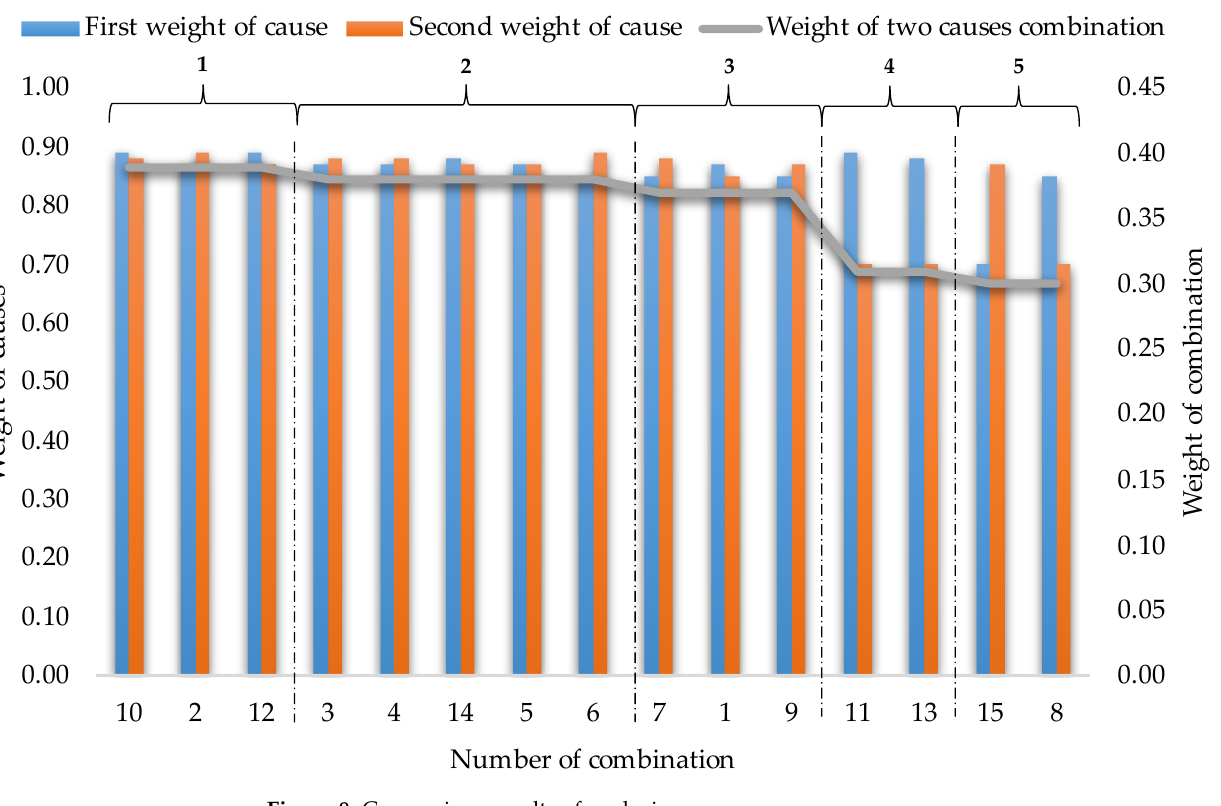
Figure 8. Comparison results of analysis.